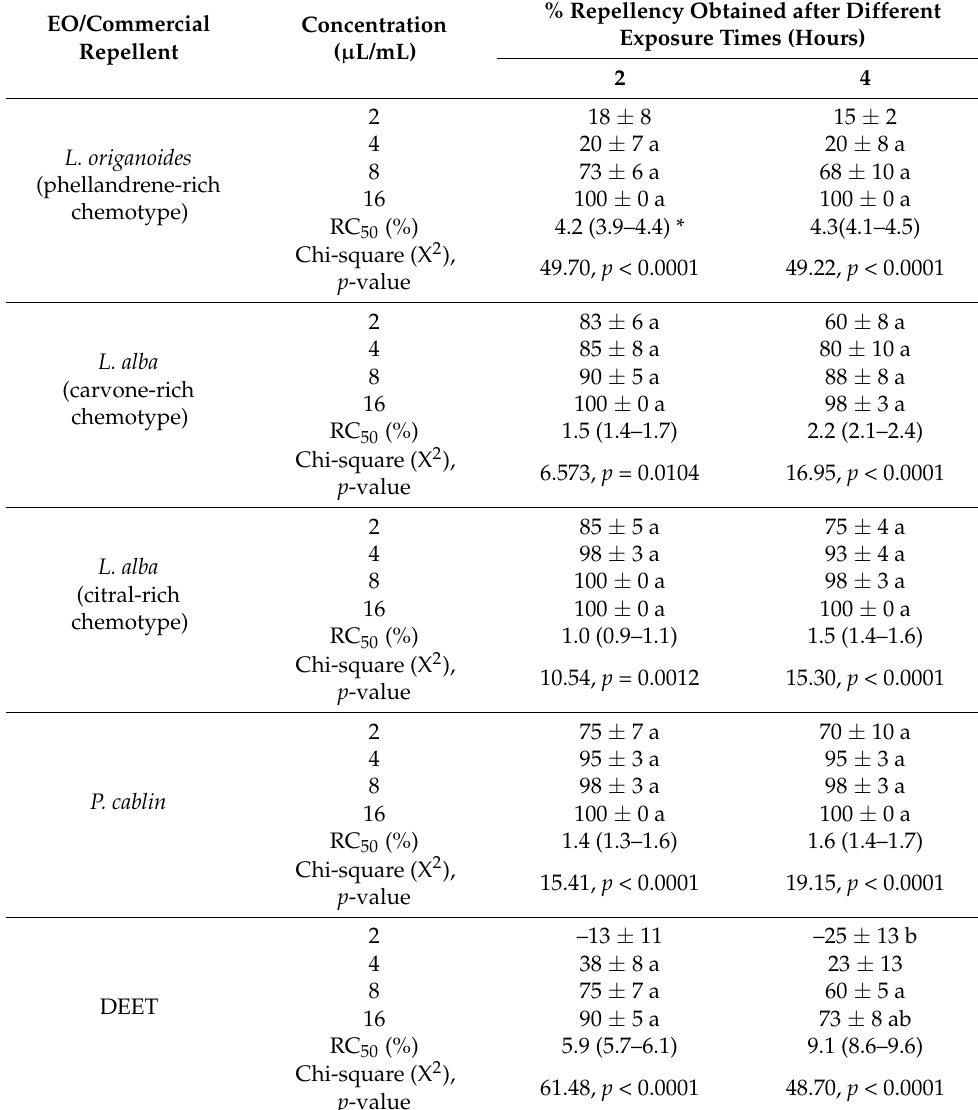
Table 2. Percentage repellency (PR) and mean repellent concentration value (RC 50 ) for EOs and DEET against U. dermestoides after two exposure